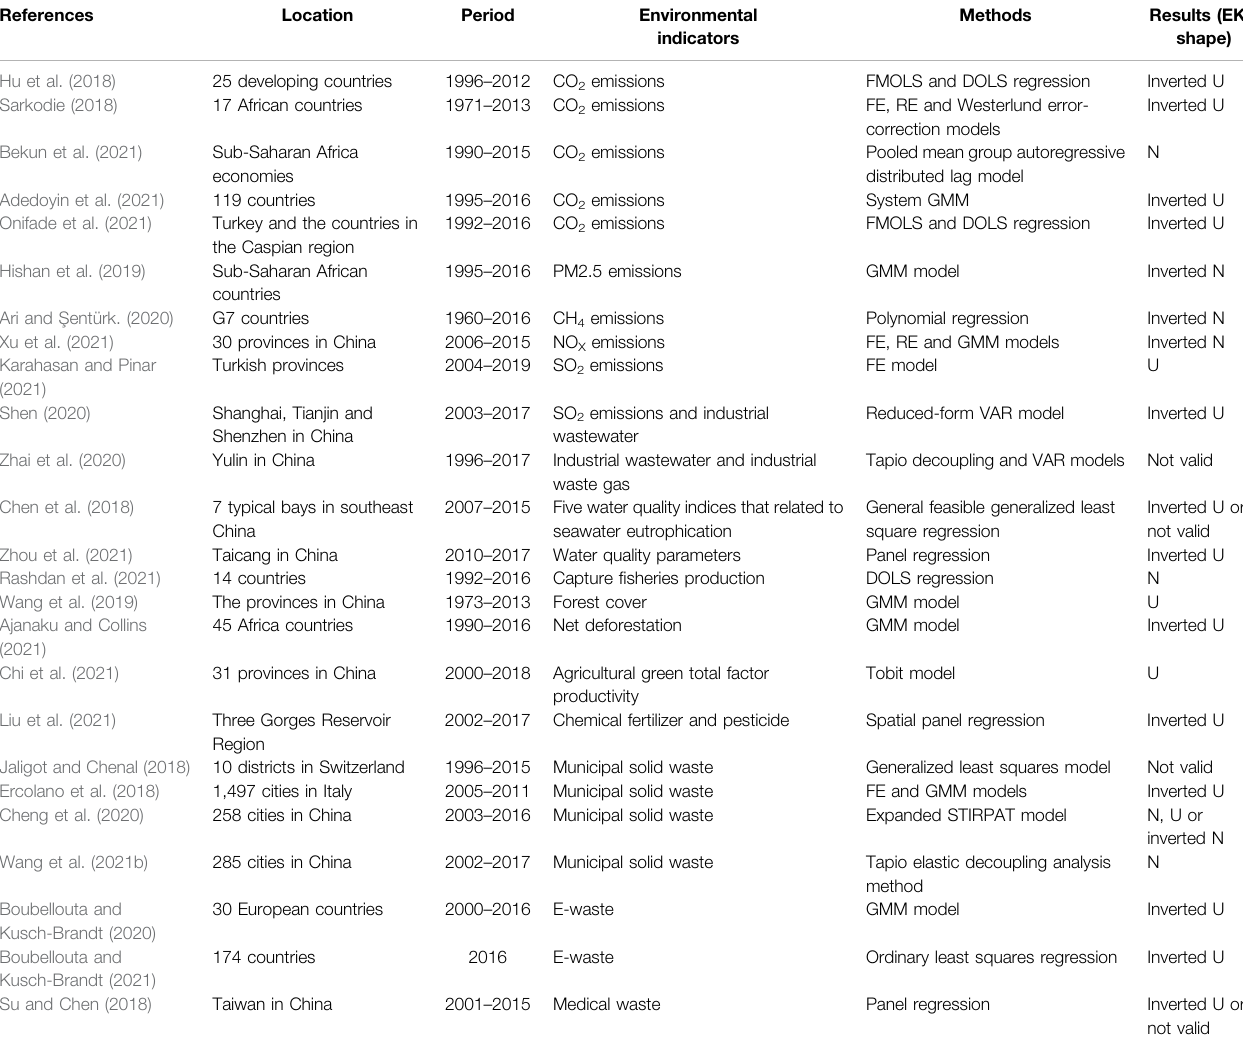
TABLE 1 | Compilation of studies on the EKC hypothesis in the past 5